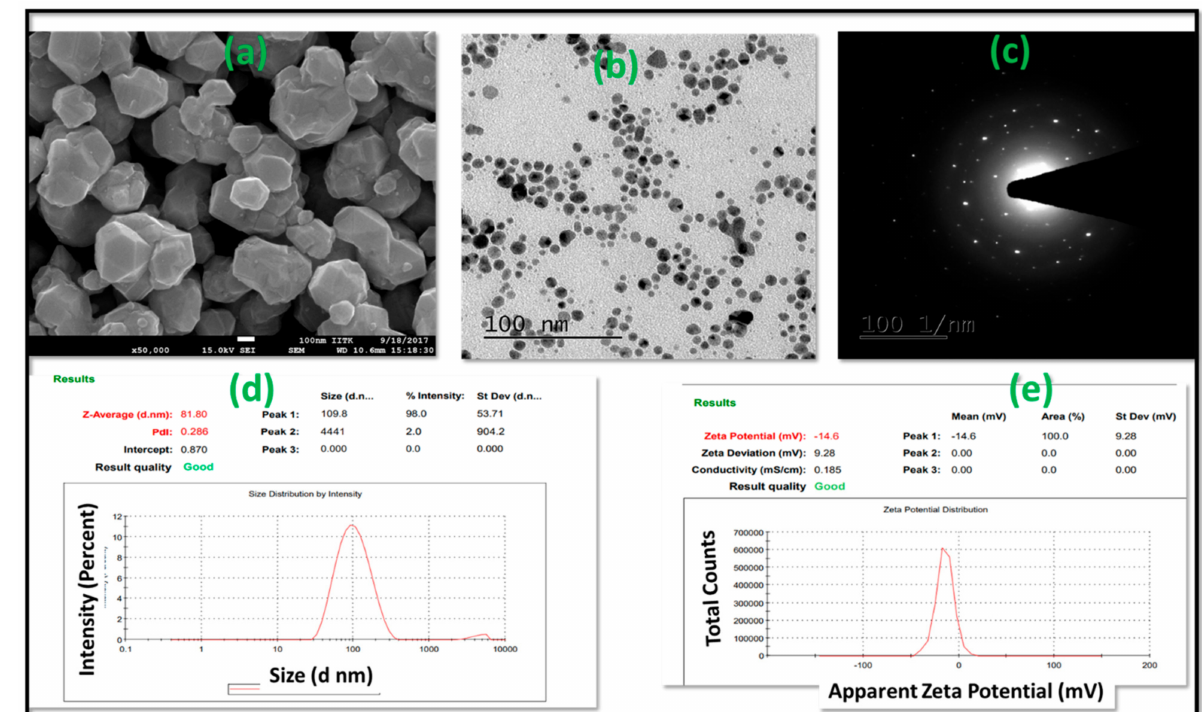
Figure 2. Characterization of LTZ@ GA-AuNPs ( a ) FE-SEM image; ( b ) HR-TEM image; ( c ) SAED; ( d ) DLS exemplifying the size distribution of the particles formed; ( e ) zeta